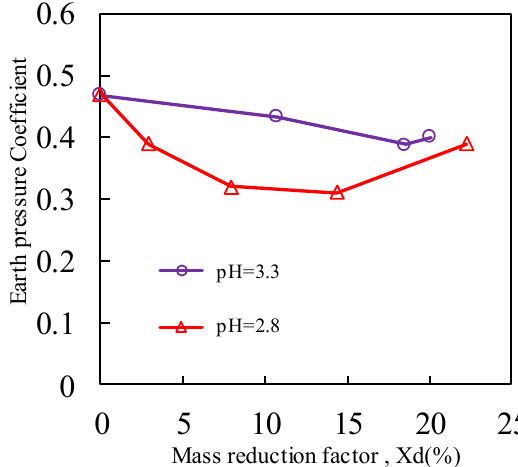
Fig. 4 . EPC variation for a different rate of dissolutions.